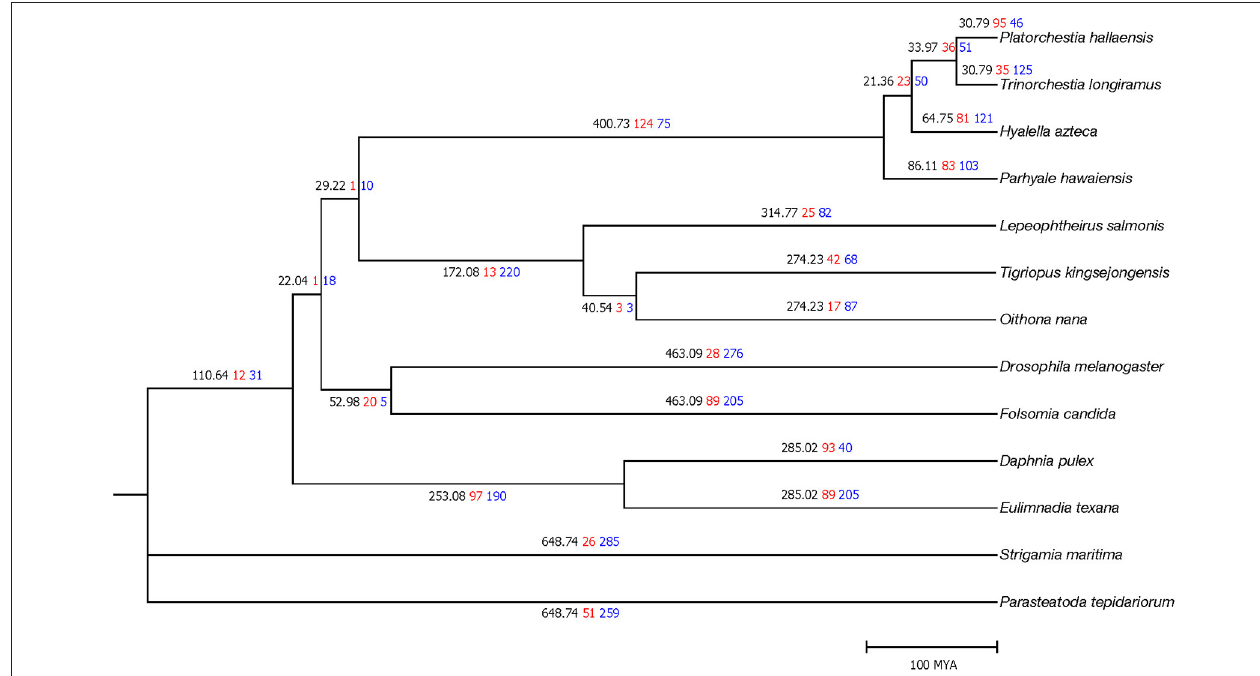
FIGURE 2 | Time tree of the 13 arthropod species where the first (black) numbers represent divergence time as well as the second (red) and third (blue) numbers represent the number of orthologous gene clusters expanded and contracted, respectively. Divergence time is scaled in millions of years.